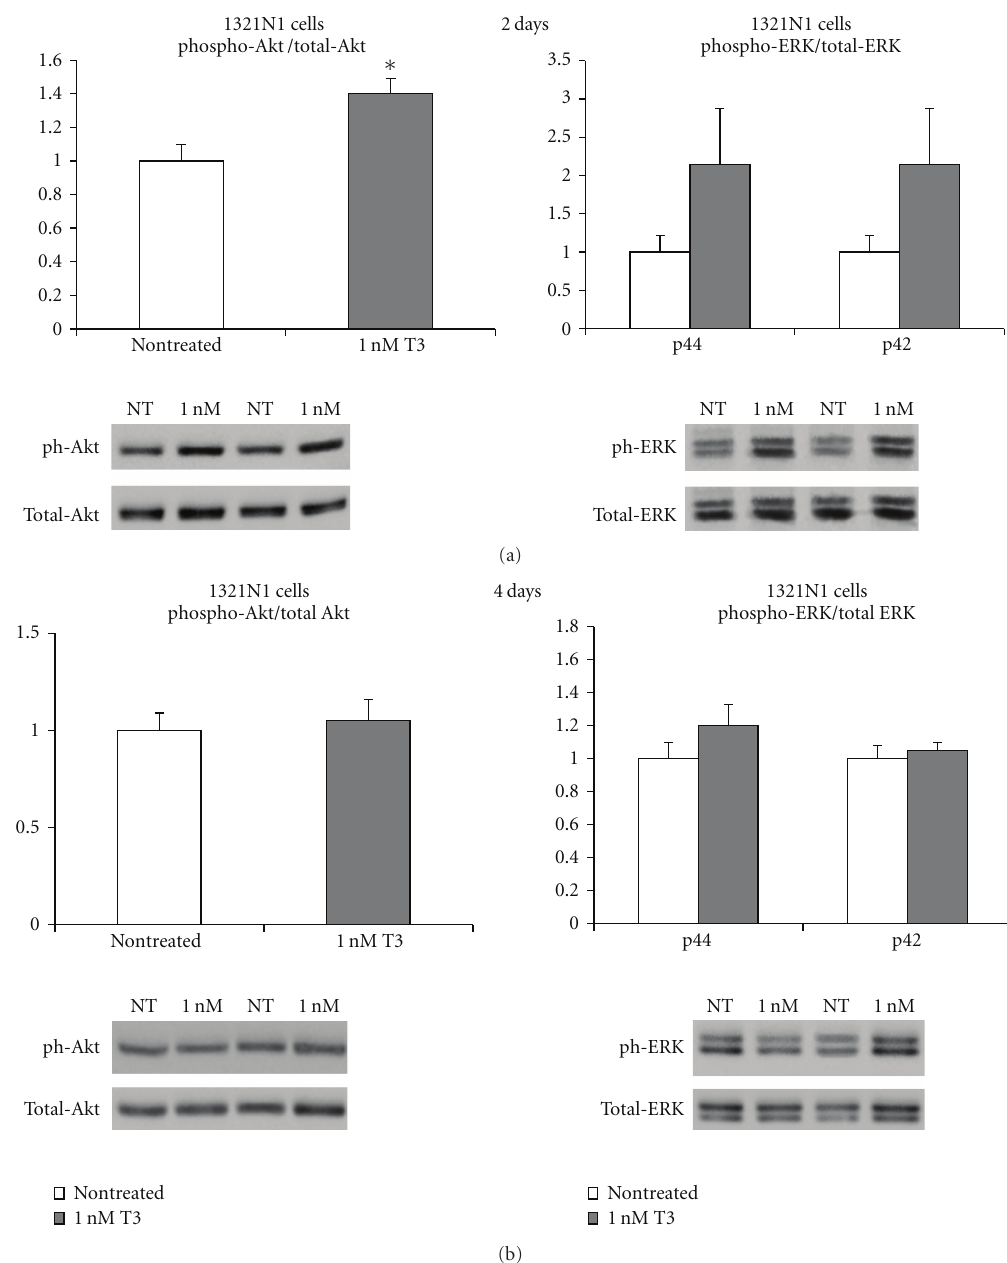
Figure 3: Thyroid hormone receptor α 1 and β 1 expression in 1321N1 cells versus U87-MG cells. Representative western blotting images are shown. P.C. corresponds to positive control. ∗ P < 0 . 05 versus 1321N1